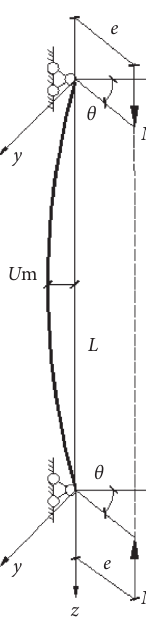
Figure 4: Loading diagram of eccentrically compressive